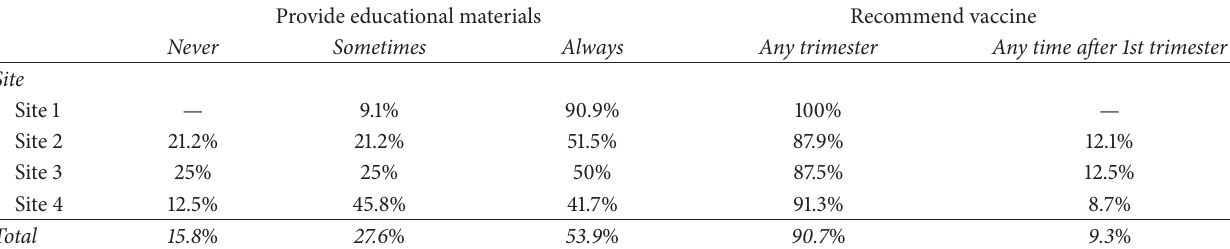
Table 3: Physician results.